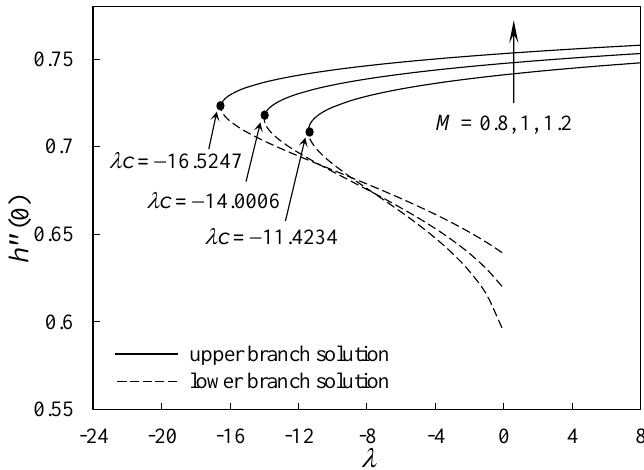
Figure 17. Variation of h (cid:48)(cid:48) ( 0 ) with λ for several values of M for Ag-water nanofluid.